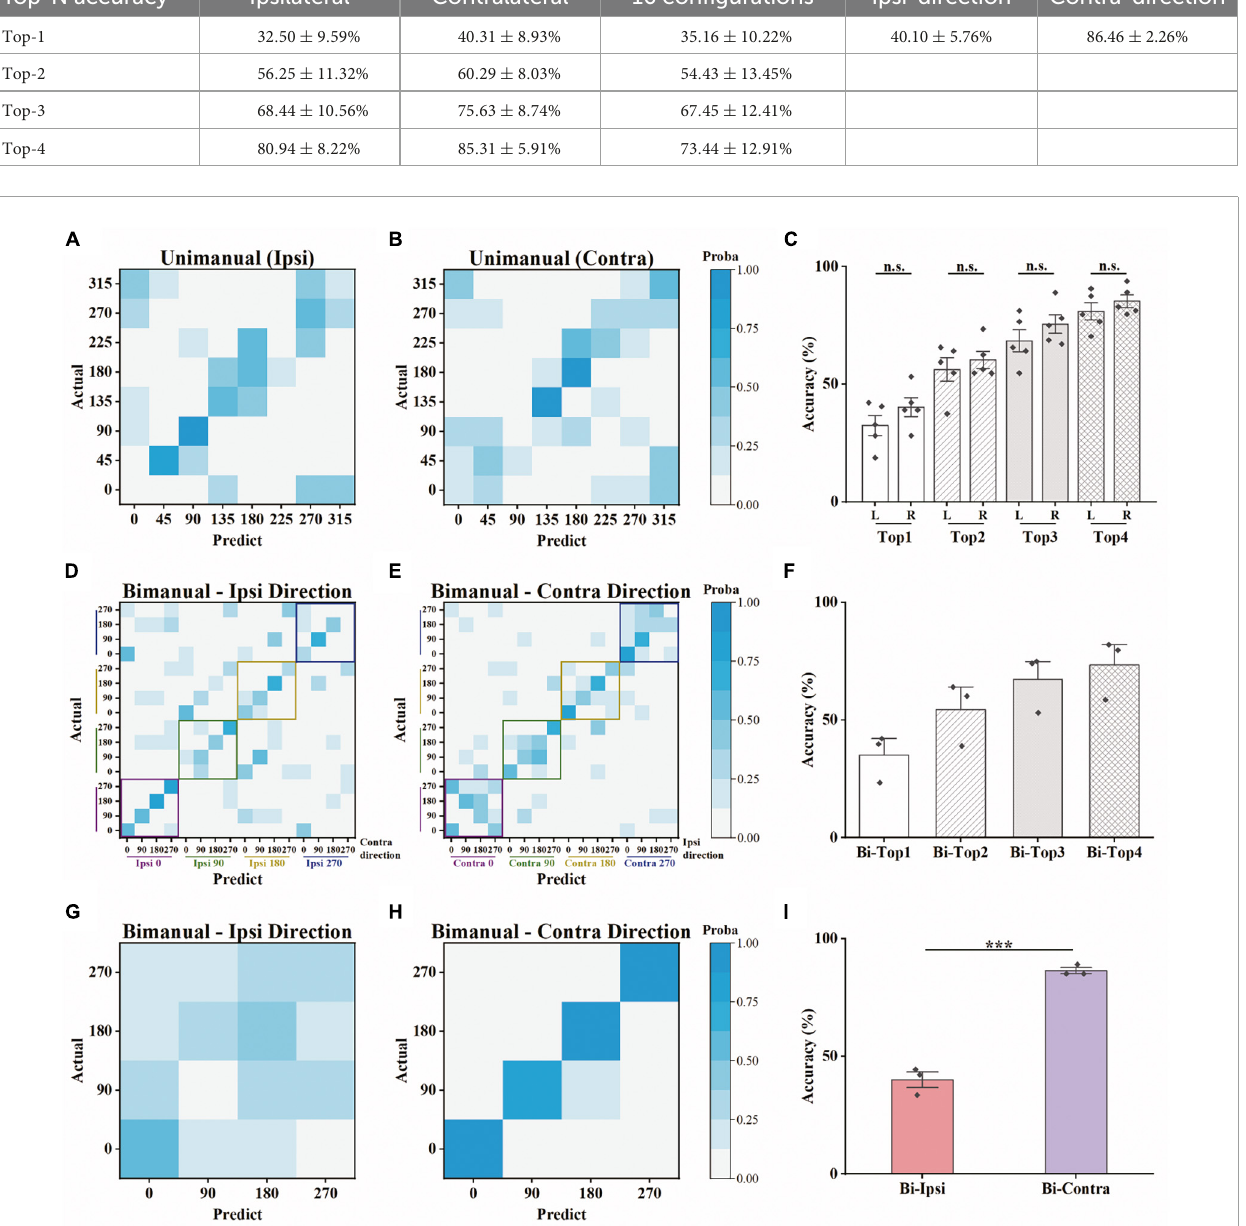
FIGURE5 Offline discrete prediction for the unimanual and bimanual center-out tasks. (A) The support vector machine classifiers were used to classify each trial’s movement direction using the neural responses. Example confusion matrix of offline prediction results on an ipsilateral block. Each square (i, j) in the matrix is colored by the percentage of trials that target j was classified as target i. (B) The same as in panel (A) , showing results from a contralateral block performed on the same day. (C) Top-N accuracy of unimanual trials obtained by the SVM classifiers, for each ipsilateral and contralateral block, respectively. Each diamond represents the mean prediction performance for a block. (D,E) As in panels (A,B) , for the classification results predicted by another SVM classifier for a bimanual block. The confusion matrices were shown according to the direction of the ipsilateral and contralateral arm movements. (F) As in panel (C) , for the bimanual center-out trials. (G) Confusion matrix for the same bimanual block in panels (D,E) , using the SVM classifier with a 4D output for the direction of ipsilateral arm. (H) As in panel (G) , for the direction of contralateral arm. (I) As in panels (C,F) , for the mean prediction performance of the SVM classifiers with 4D output for the bimanual trials. The classifiers were trained on all the selected neurons for each block. *** p < 0.001, t -test.